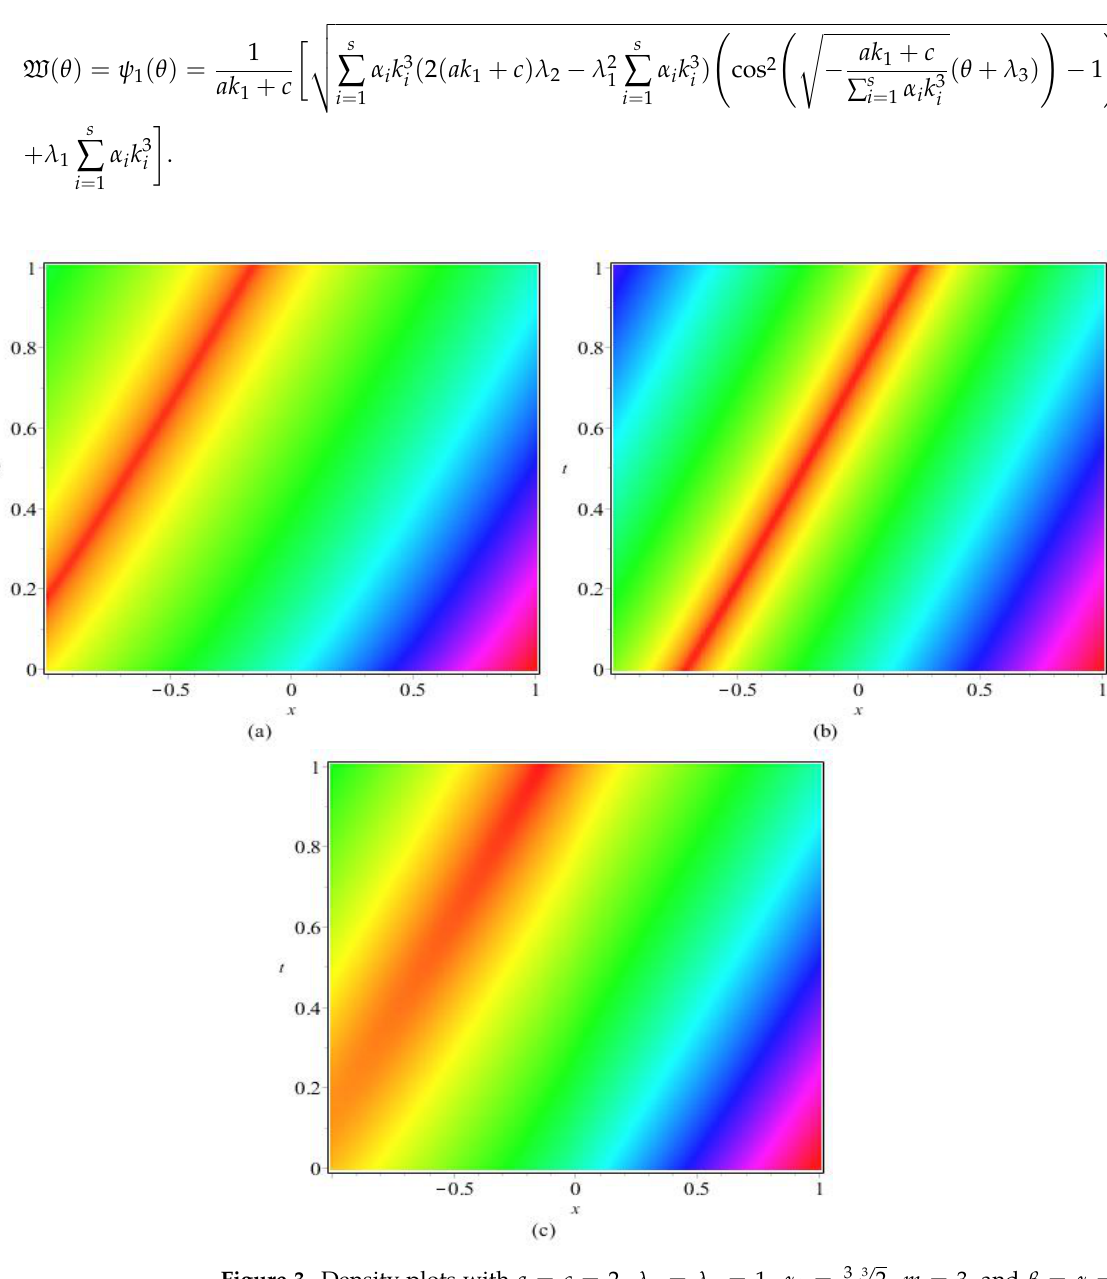
Figure 3. Density plots with a = c = 2, λ 2 = λ 3 = 1, α 1 = 3